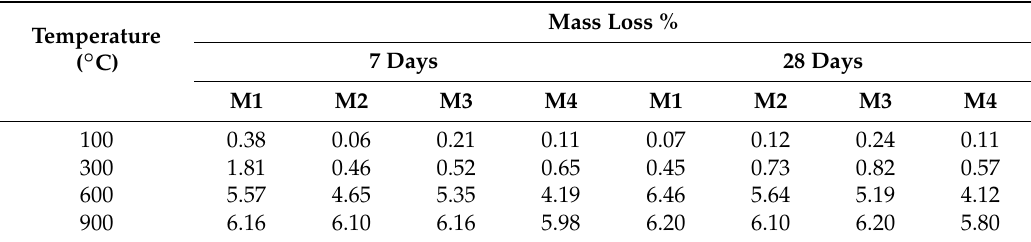
Table 9. Mass loss (percentage) by